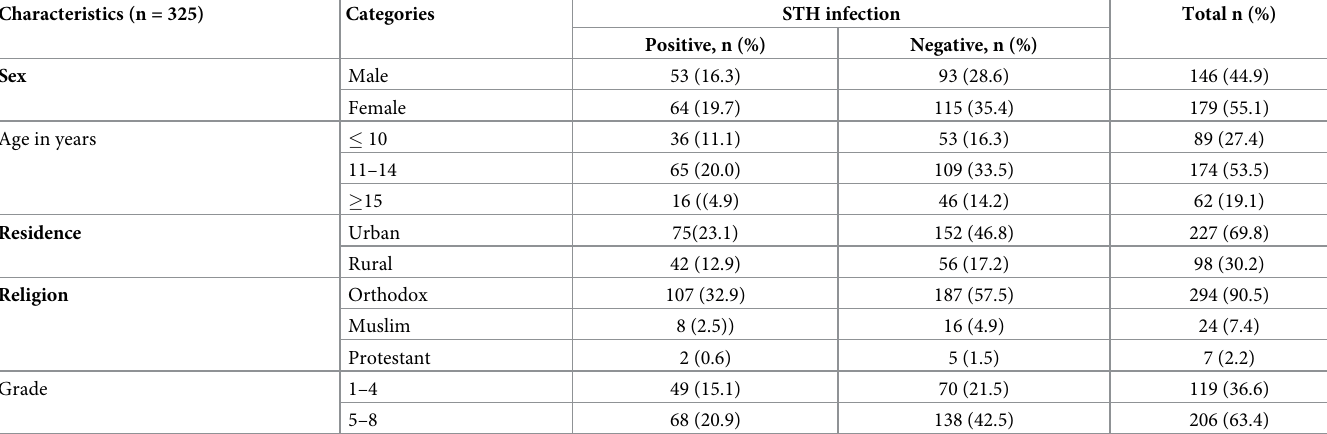
Table 2. Socio-demographic distribution of STH infections among school children of Tachgayint woreda, Northcentral Ethiopia, 2021. Characteristics (n = 325)